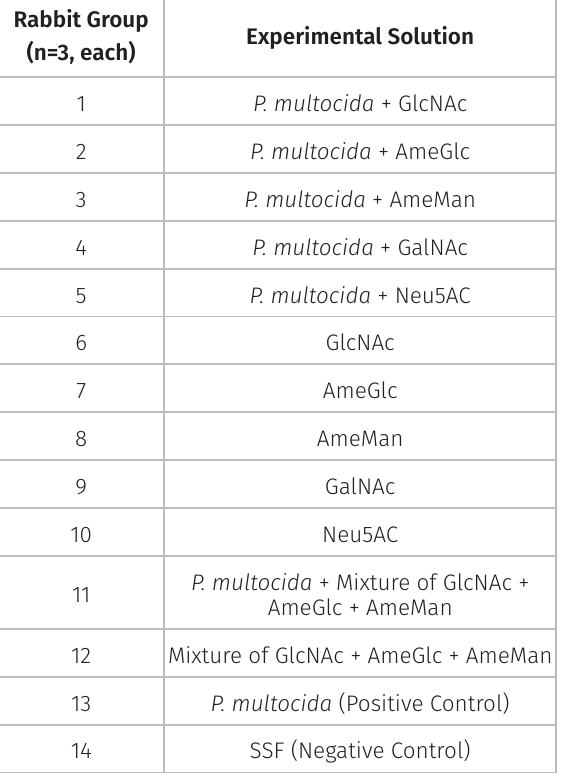
Table I. Experimental mixtures of P. multocida with each one of the sugars and mixture of sugars. Rabbit Group Experimental (n=3, each)